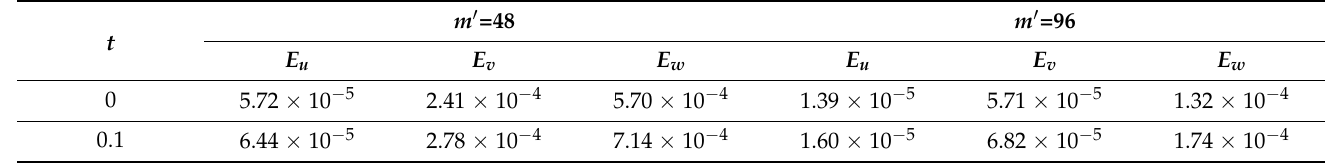
Table 4. Output values u ( t ) , v ( t ) , and w ( t ) of the proposed method for α = 1, β = 1, and γ = 1, and several m (cid:48) values with the exact solution of Example